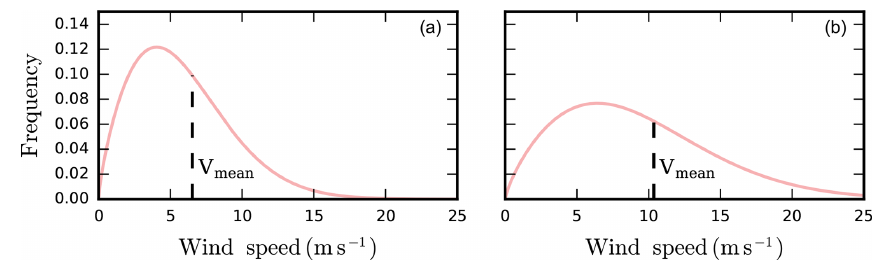
Figure 1. The Weibull wind speed distributions for two different average wind speeds. In (a) there is an average wind speed of 6.53ms − 1 , and (b) shows an average wind speed of 10.35ms − 1 . The shape factor k in each Weibull distribution was chosen as